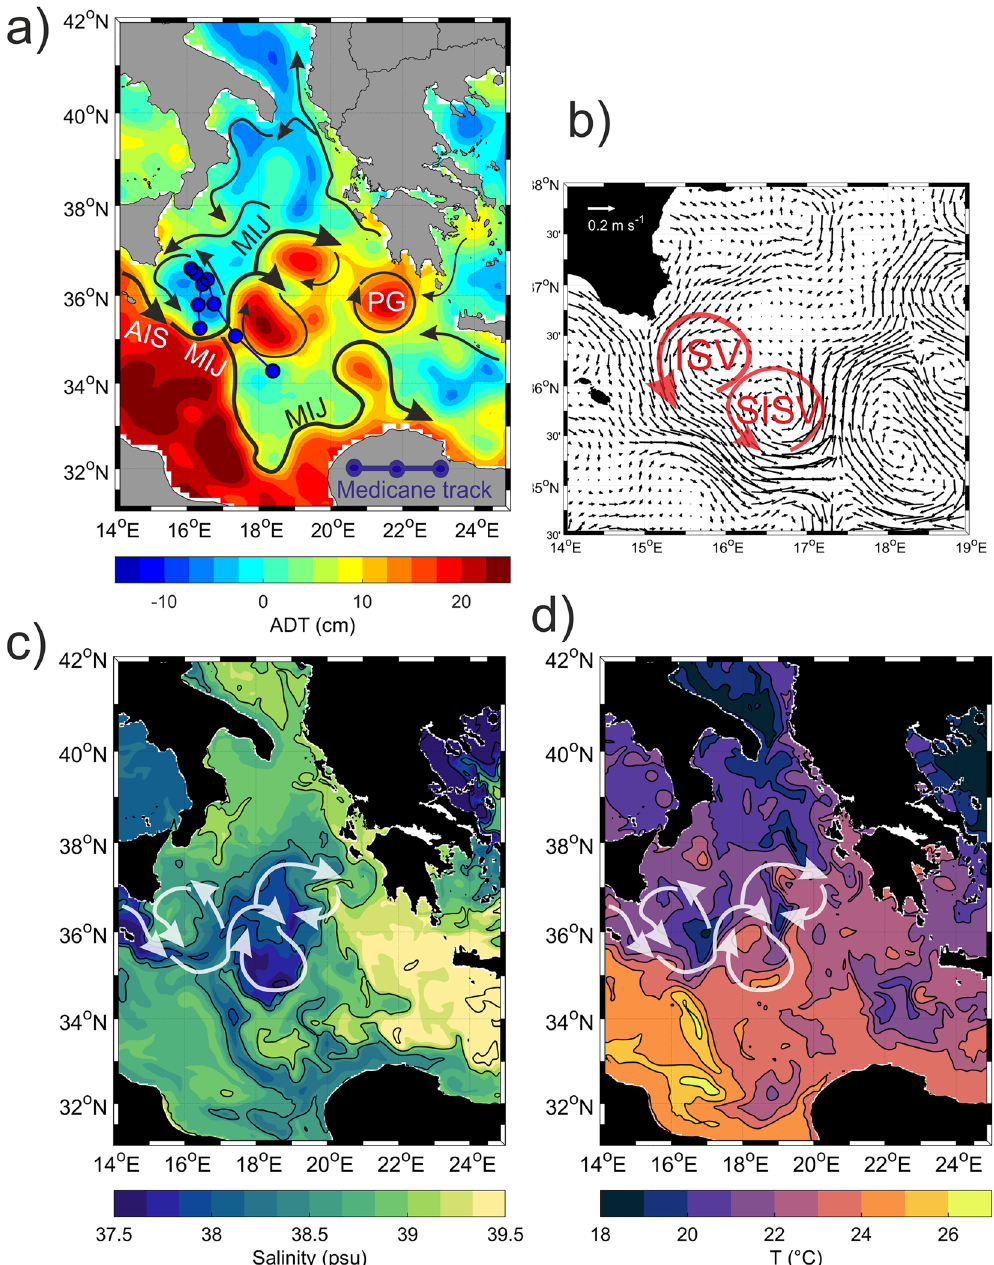
Figure 3. Oceanographic conditions on October 29 th , 2021: ( a ) Schematic representation of the main currents and circulation structures (black arrows) superimposed on the ADT field (colors); 6 h Medicane Apollo track in the period 28 October 2021 18:00 UTC—30 October 2021 18:00 UTC (blue line and dots); ( b ) zoom on the absolute geostrophic velocities in the Medicane impacted area; ( c ) salinity and ( d ) temperature fields derived from the physical CM model in the surface layer (0–10 m depth); the main currents are superimposed with white arrows. Acronyms: AIS—Atlantic Ionian Stream; MIJ—Mid Ionian Jet; PG—Pelops Gyre; ISV—Ionian Shelf break Vortex; SISV—Southern Ionian Shelf break